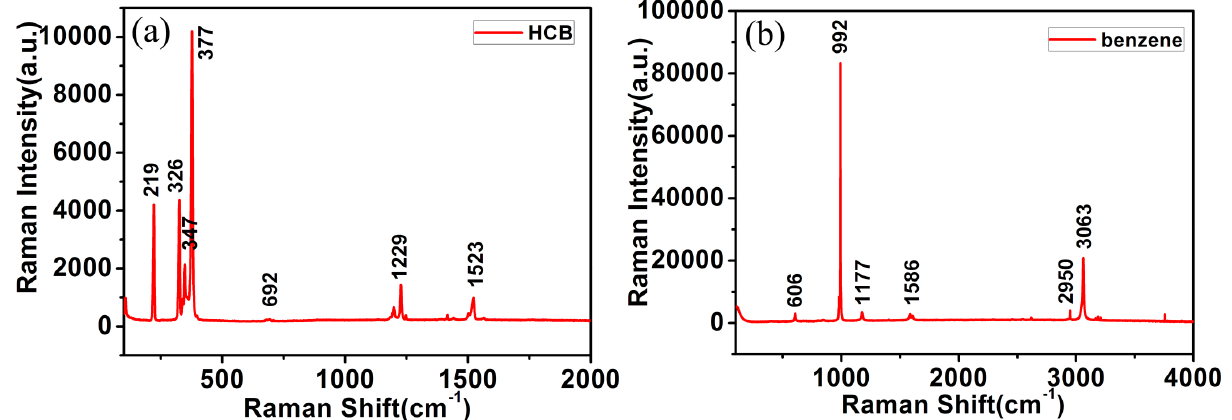
Figure 2. Experimental Raman spectrum of (a) hexachlorobenzene; (b) benzene, in powder, with the main peaks